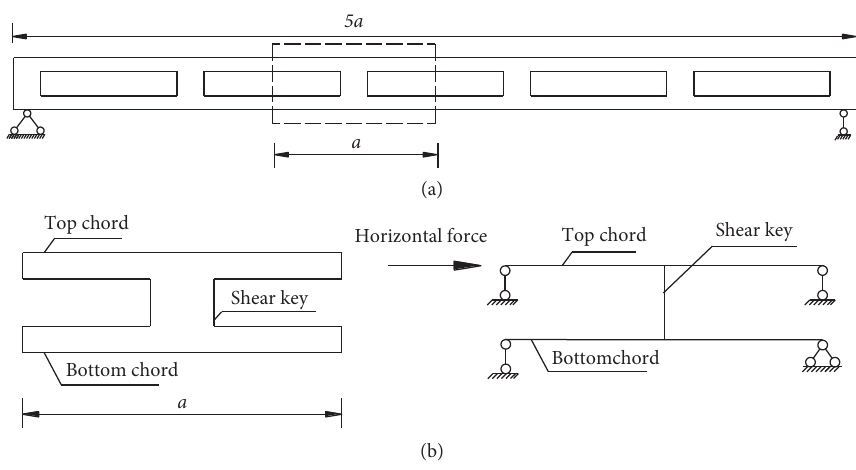
Figure 3: Mechanical model of test. (a) Object of the study. (b) Force